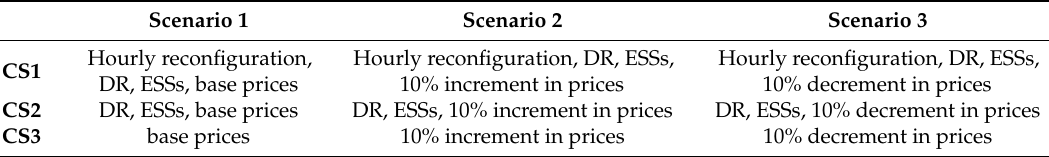
Table 4. Summary of the defined Case studies (CSs) and scenarios.